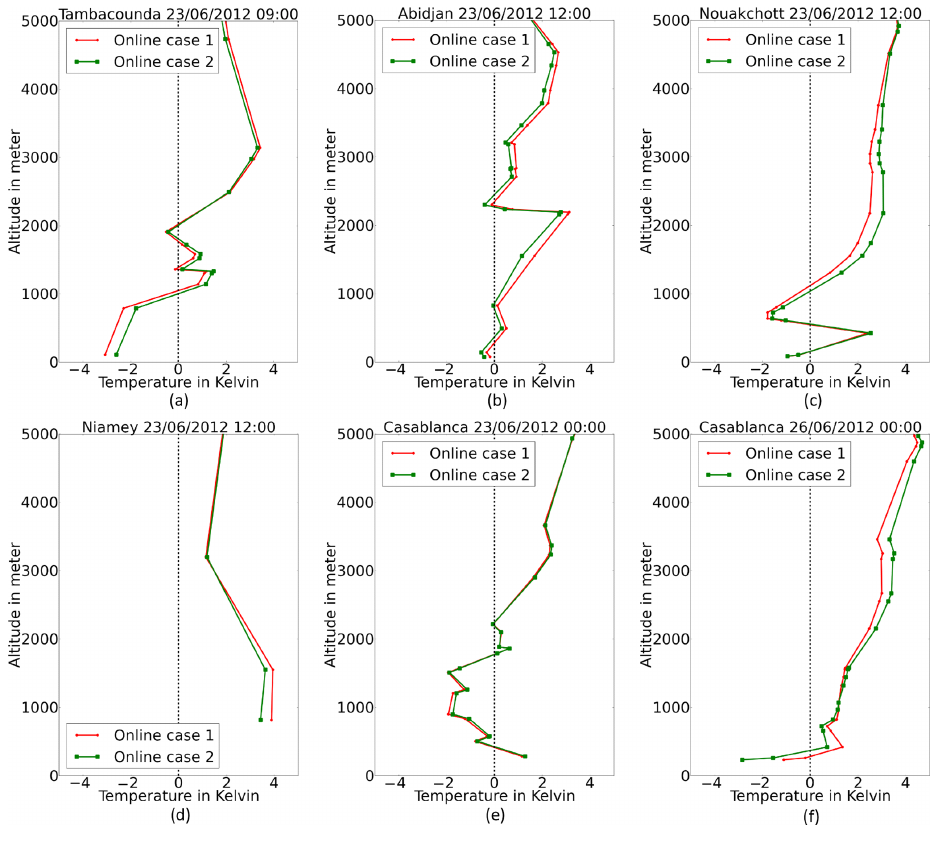
Figure 12. Difference in vertical profiles of temperature (modelled values − radiosounding values).